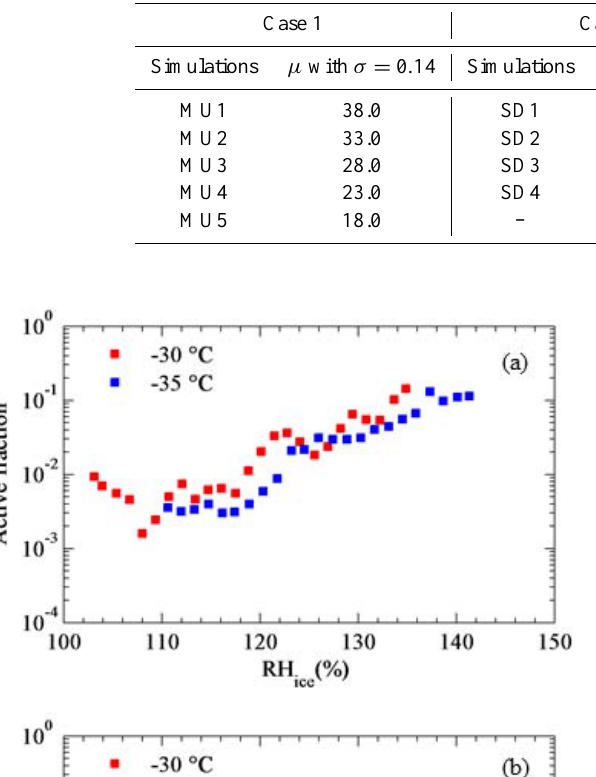
Table 3. Cloud sensitivity tests of µ (deg), σ (rad) and N 0 (L − 1 ) variables. Three cases were simulated. In the case 3 simulations the parameters µ and σ are 33.0 and 0.41 rad, respectively, were held constant.